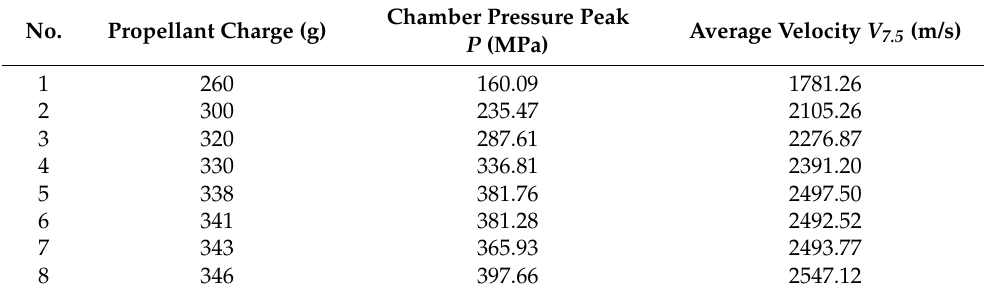
Table 2. Relationship of propellant charge, chamber pressure, and velocity of the fragment.